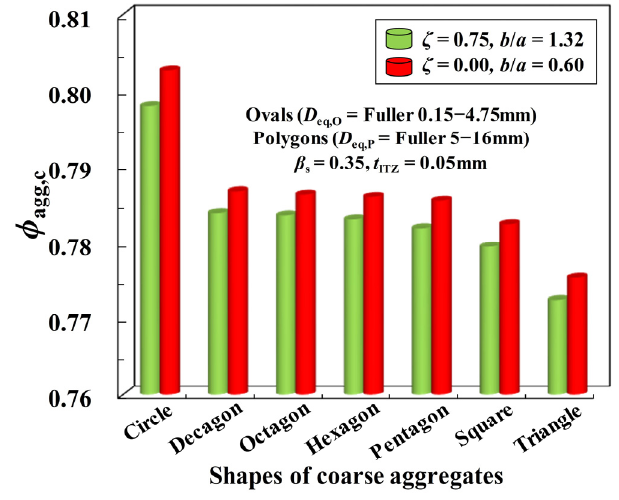
Figure 9. Effect of the geometric shapes of polygonal particles on the ITZ percolation.